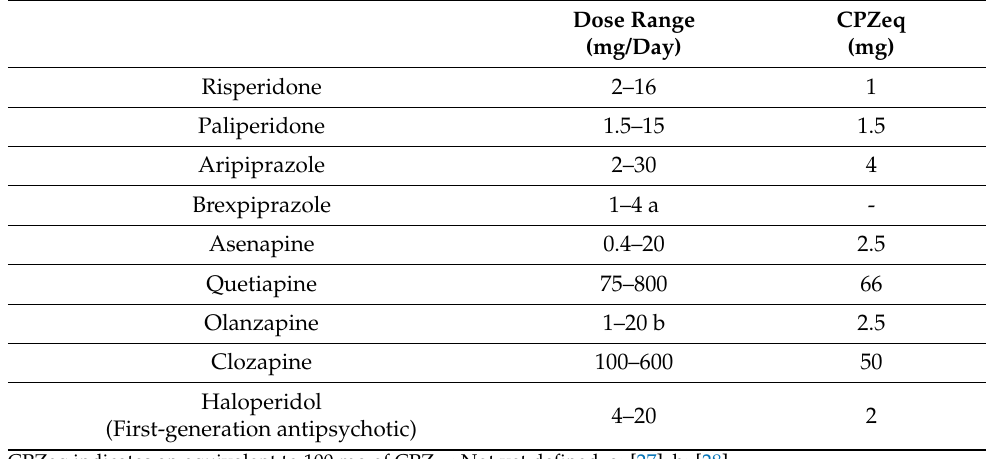
Table 1. Dosages and chlorpromazine equivalent doses (CPZeq) of selected second-generation antipsychotics. [26].